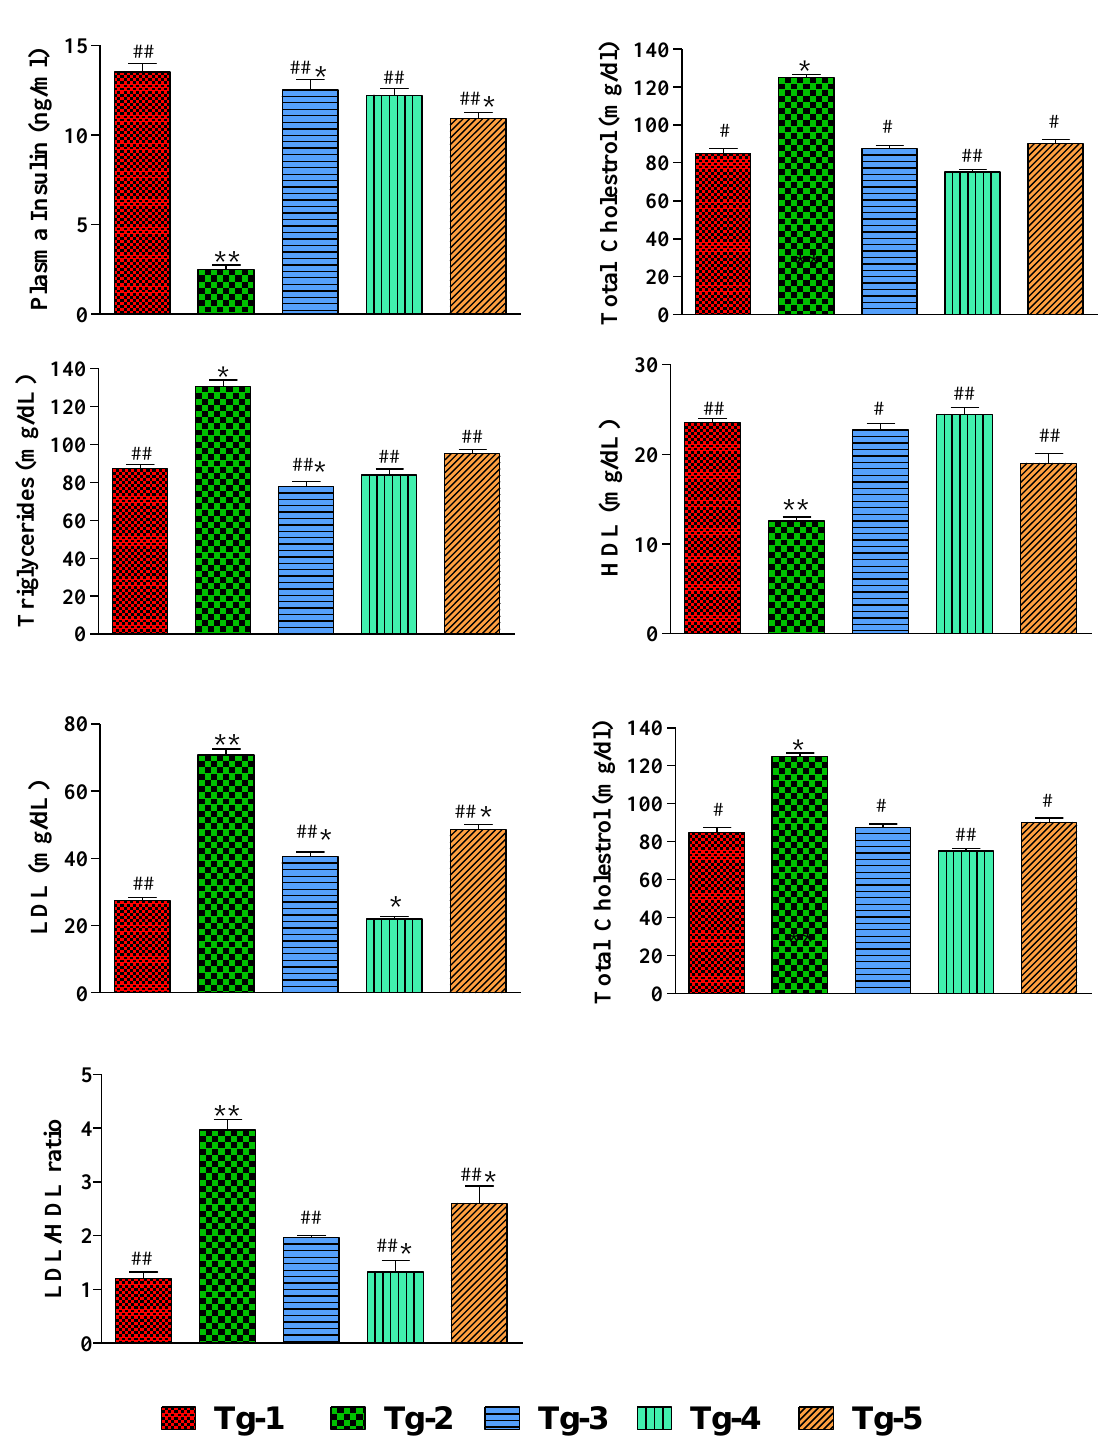
Figure 2. Effect of compound 3 treatments on plasma insulin and serum lipid profile of diabetic mice. The results are presented as mean ± SEM ( n = 3), ** p < 0.01, and * p < 0.05; vs. control group, # p < 0.05; ## p < 0.01 vs. STZ group. Metformin (MET) and streptozotocin (STZ). Low-density lipoprotein (LDL), and high-density lipoprotein (HDL). Control (Tg-1), STZ (Tg-2), compound 3 (Tg-3), STZ + metformin (Tg-4), and STZ + compound 3 (Tg-5).